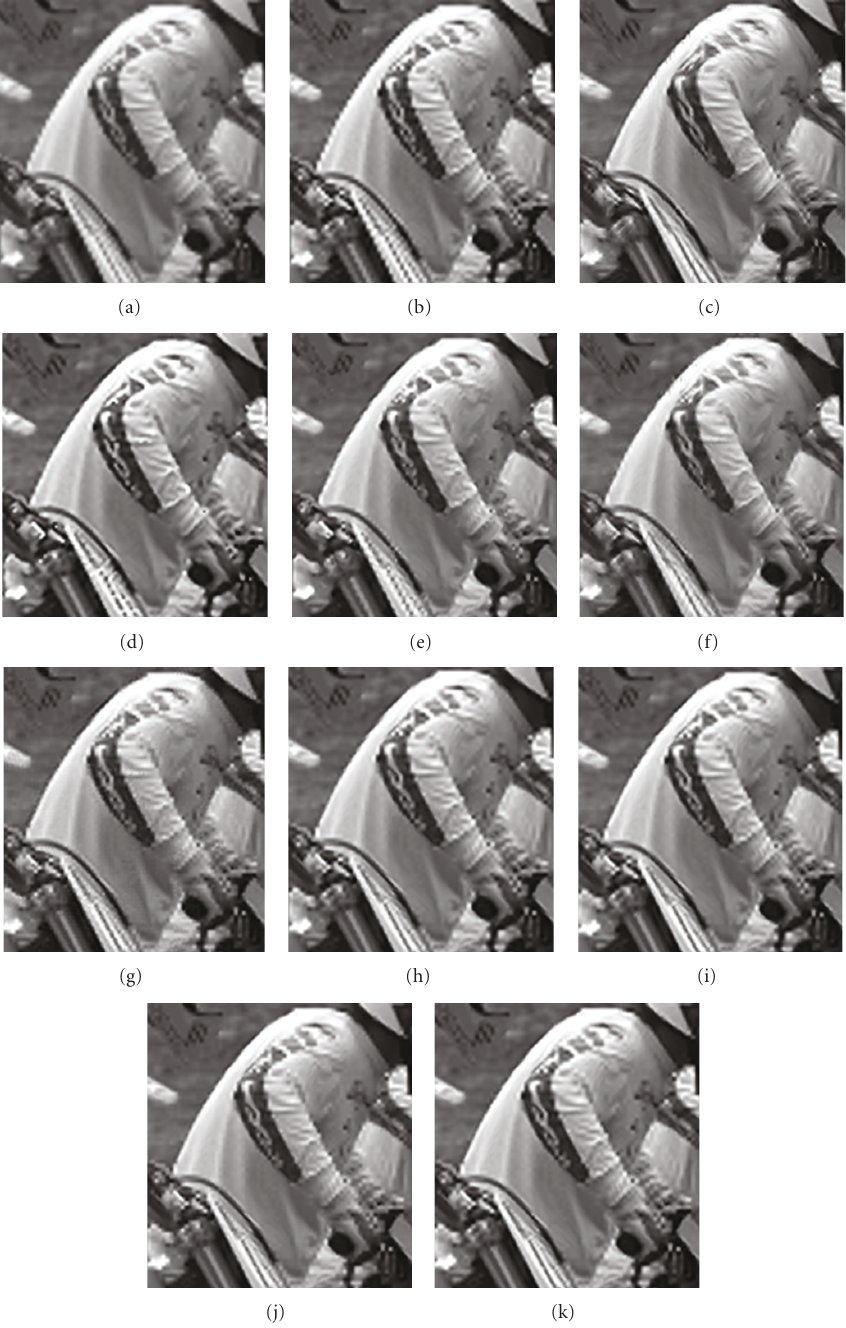
Figure 10: Portions of resolution enhanced “Bike” image by (a) bilinear; (b) bicubic; (c) edge-directed method ( M = 8) [12]; (d) ICBI [20]; (e) LMMSE-based method ( ζ = 1, ξ = 1 . 5) [17]; (f) SAI ( λ = 0 . 5) [18]; (g) NN-based method [16]; the proposed method utilized (h) bilinear kernel and (i) bicubic kernel without edge enhancement; (j) bilinear kernel and (k) bicubic kernel with edge enhancement.